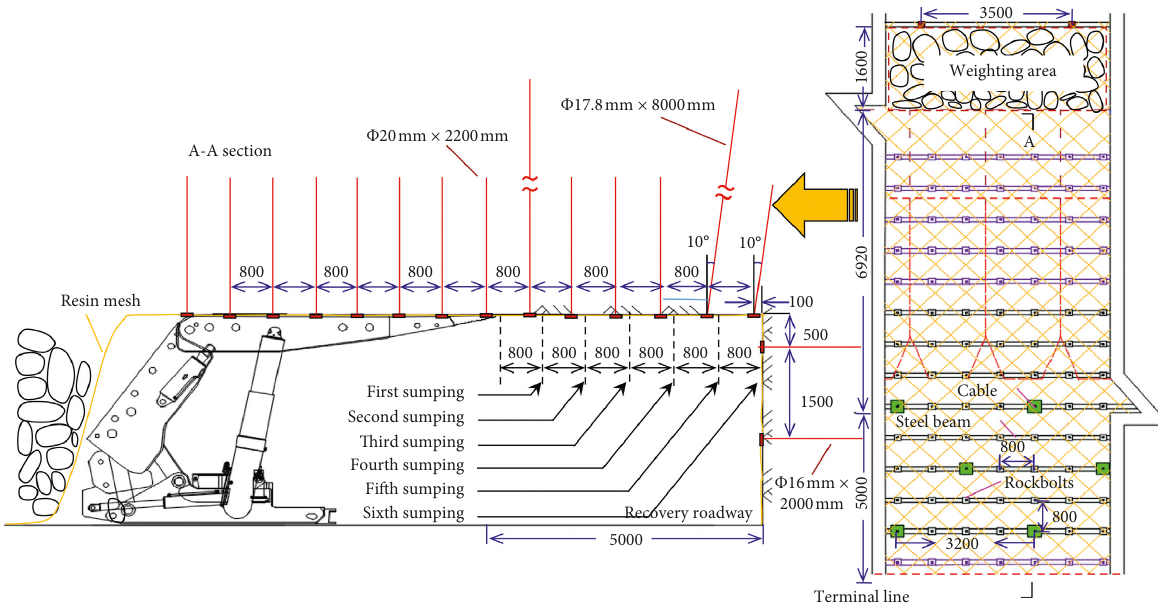
Figure 7: Initial support design of the recovery roadways.